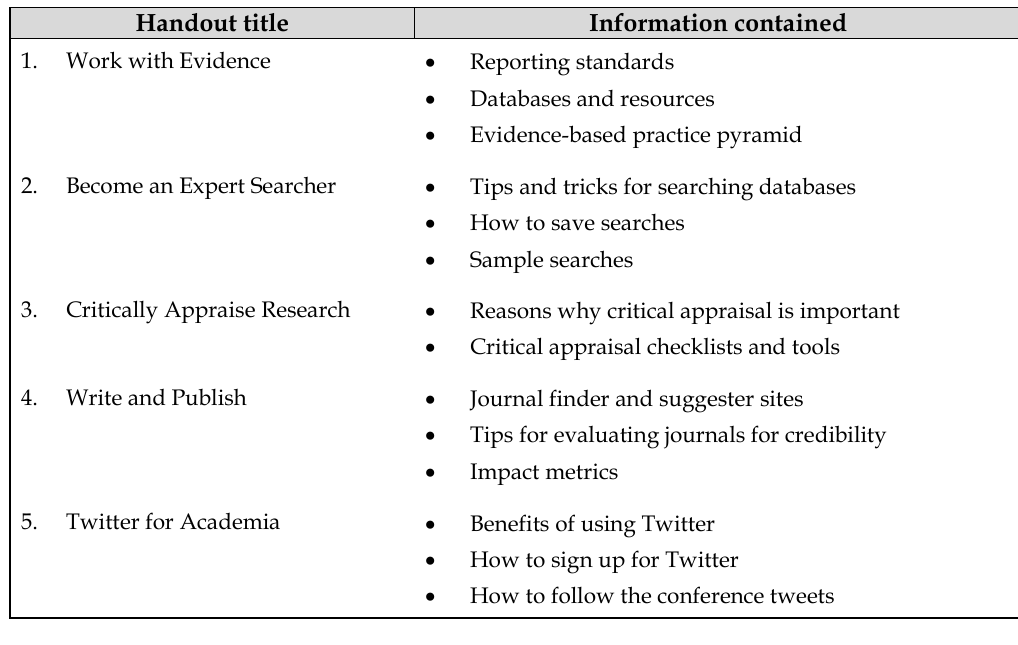
Table 1 Summary of available handouts